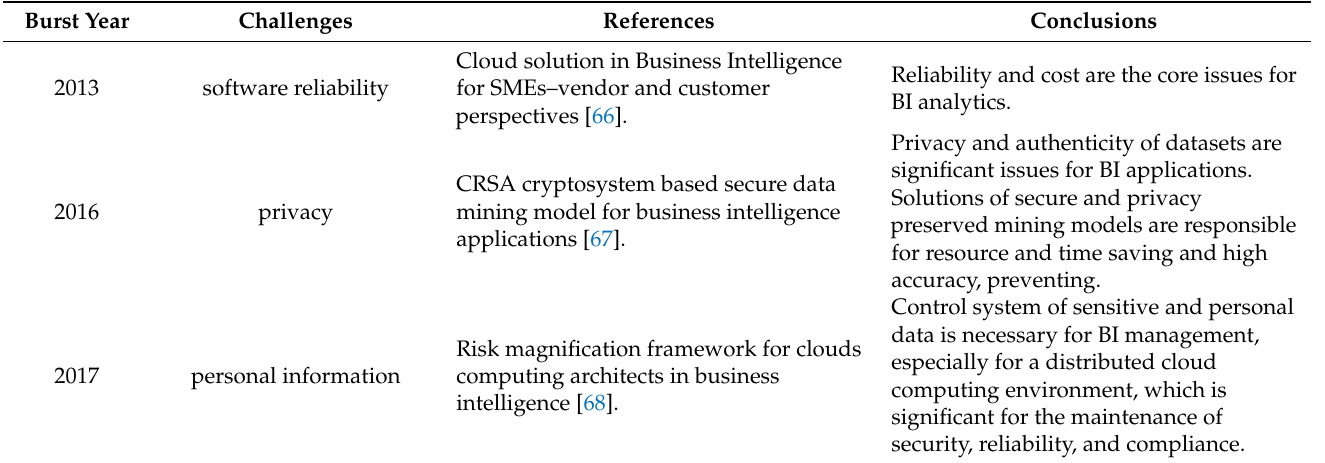
Table 10. Challenge burst trend explorations.